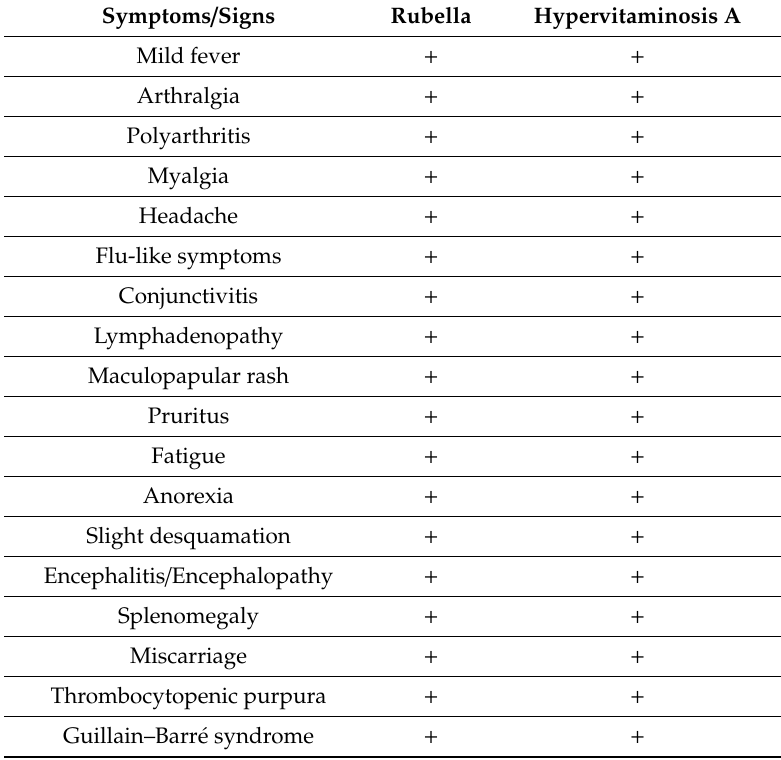
Table 1. Similarities between rubella symptoms and complications and acute hypervitaminosis A. Symptoms / Signs Rubella Hypervitaminosis A Mild fever + + Arthralgia + + Polyarthritis + + Myalgia + + Headache + + Flu-like symptoms + + Conjunctivitis + + Lymphadenopathy + + Maculopapular rash + + Pruritus + + Fatigue + + Anorexia + + Slight desquamation + + Encephalitis / Encephalopathy + + Splenomegaly + + Miscarriage + + Thrombocytopenic purpura + + Guillain–Barr é